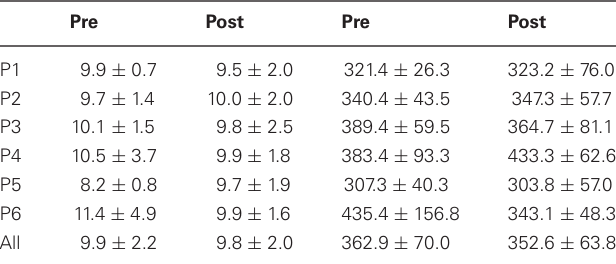
Table A2 | Mean ± Standard deviation of amplitude in degrees and of peak velocity in degrees per second for both targets in the two periods, for every participant and the group of participants